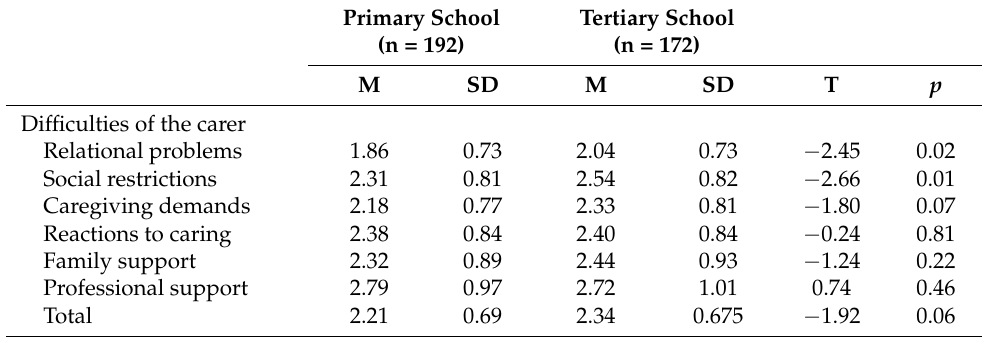
Table 8. Results of the study of caregiver difficulties as a function of education.